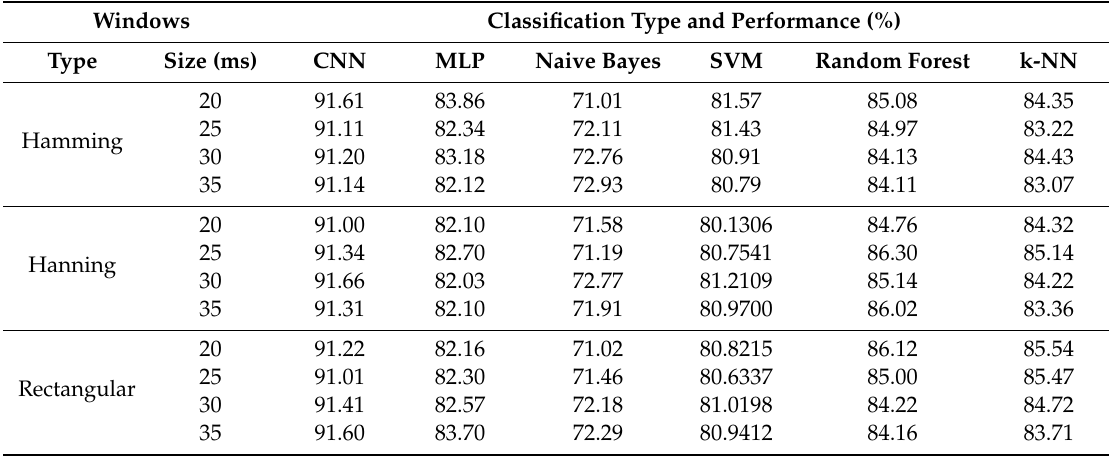
Table 7. Performance accuracy for female speakers based on GRU + EZMFCC.